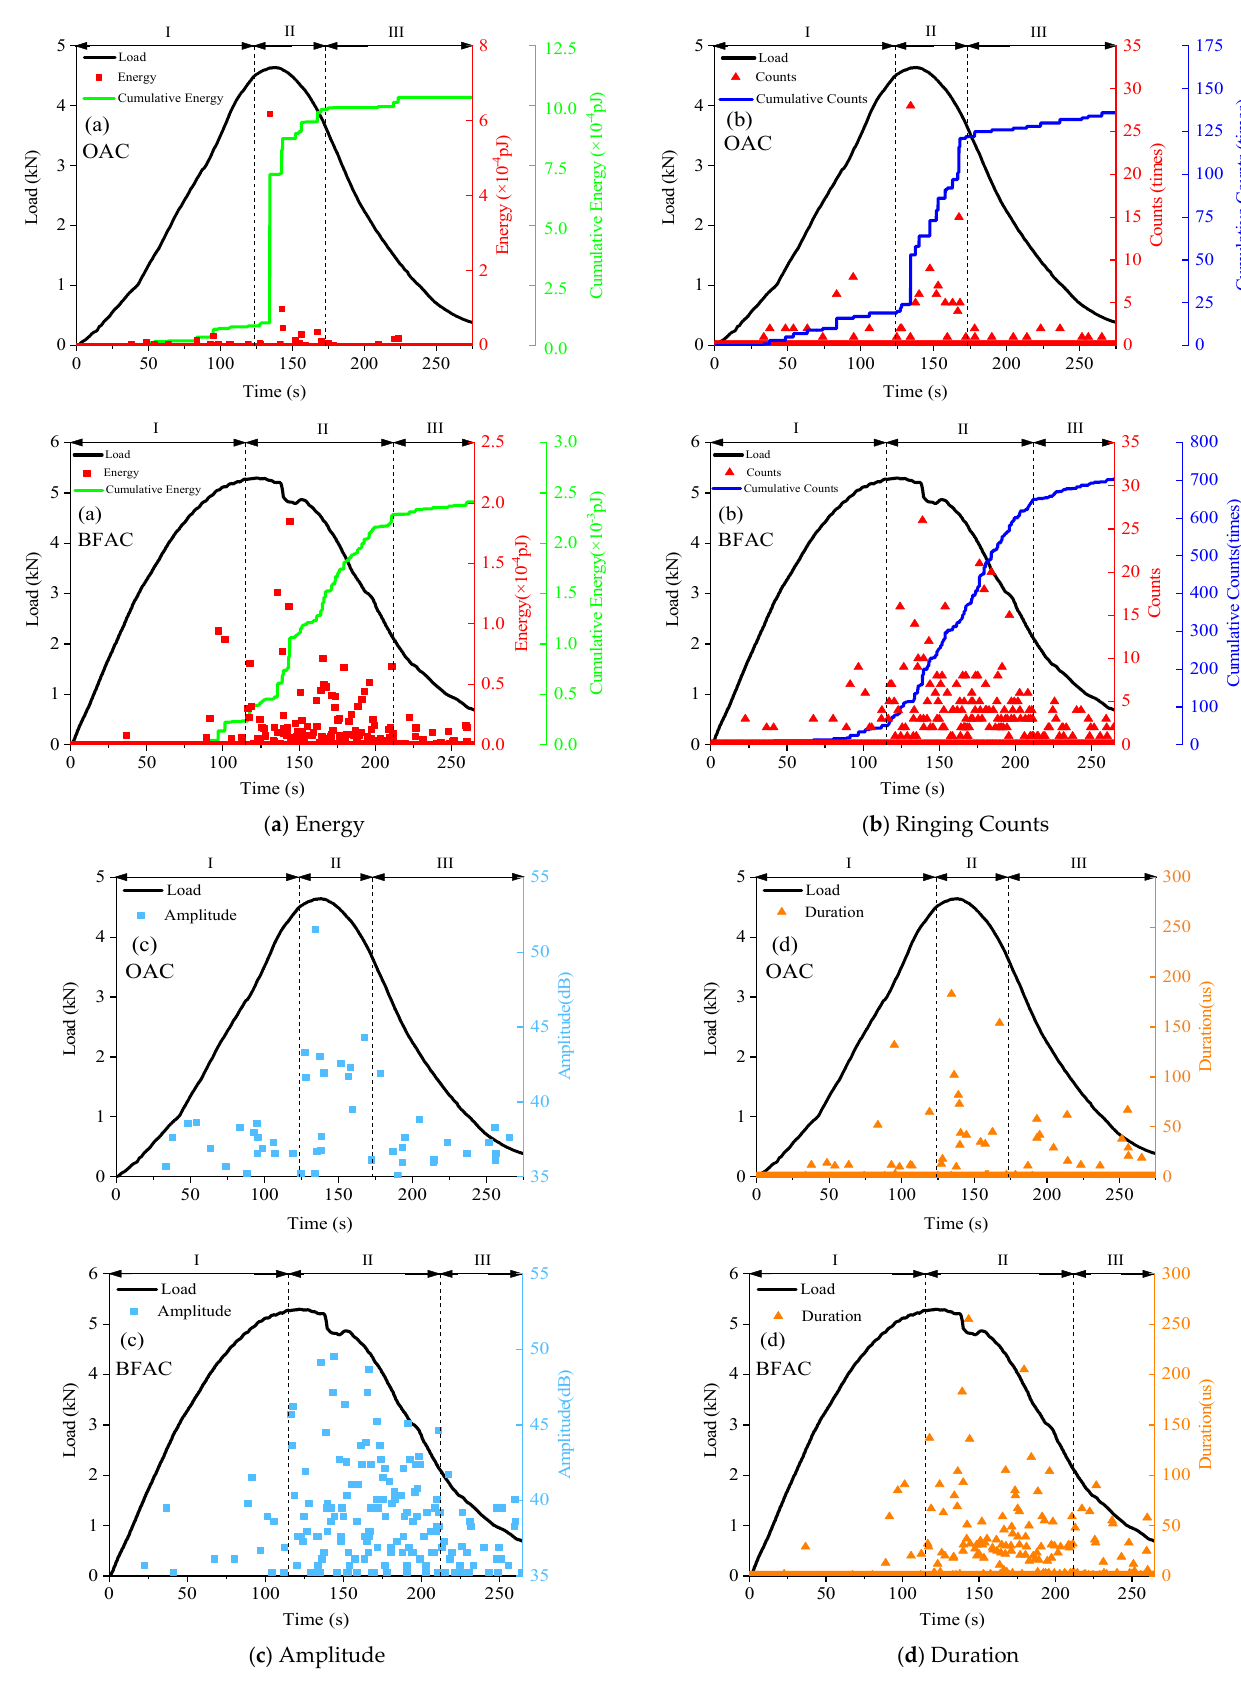
Figure 11. Characteristics of AE parameters of OAC and BFAC; ( a ) Energy; ( b ) Ringing Counts; ( c ) Amplitude; ( d ) Duration.